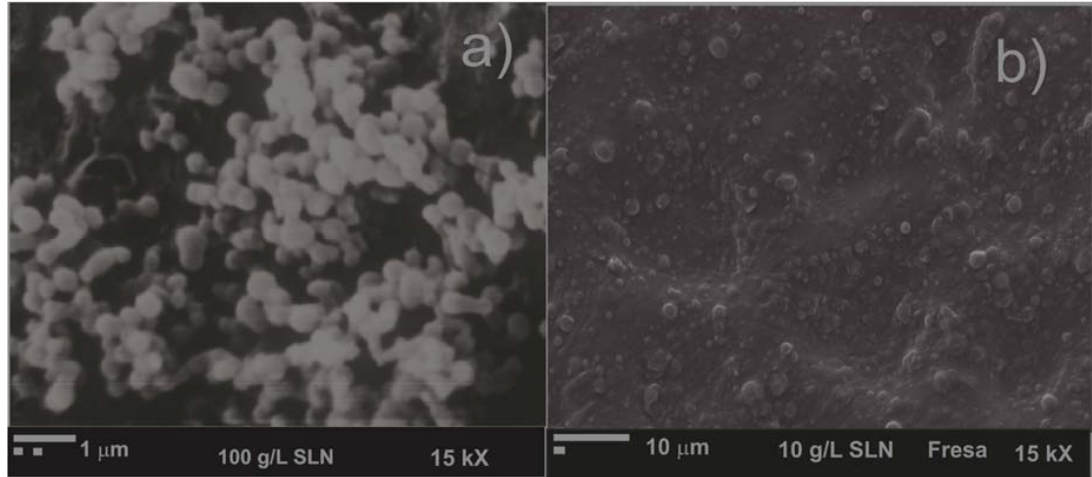
Figure 1. Micrographs of BSLN: ( a ) dispersion of 100 g/L BSLN, and ( b ) dispersion 10 g/L of BSLN on the fruit surface.